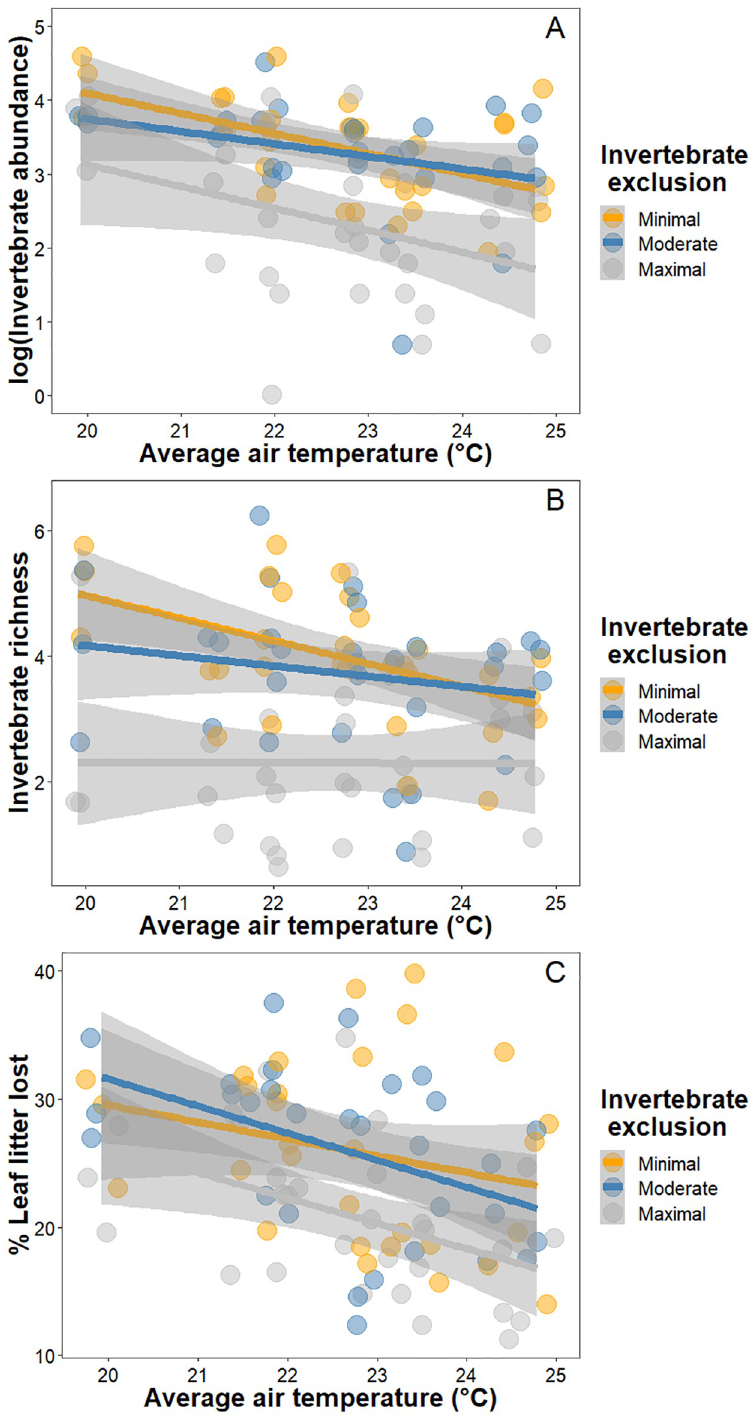
Fig 2. Air temperature and invertebrate diversity and decomposition rates. Average air temperature reduced A) invertebrate abundance, B) invertebrate richness, and C) and percent leaf litter lost in the litterbags.